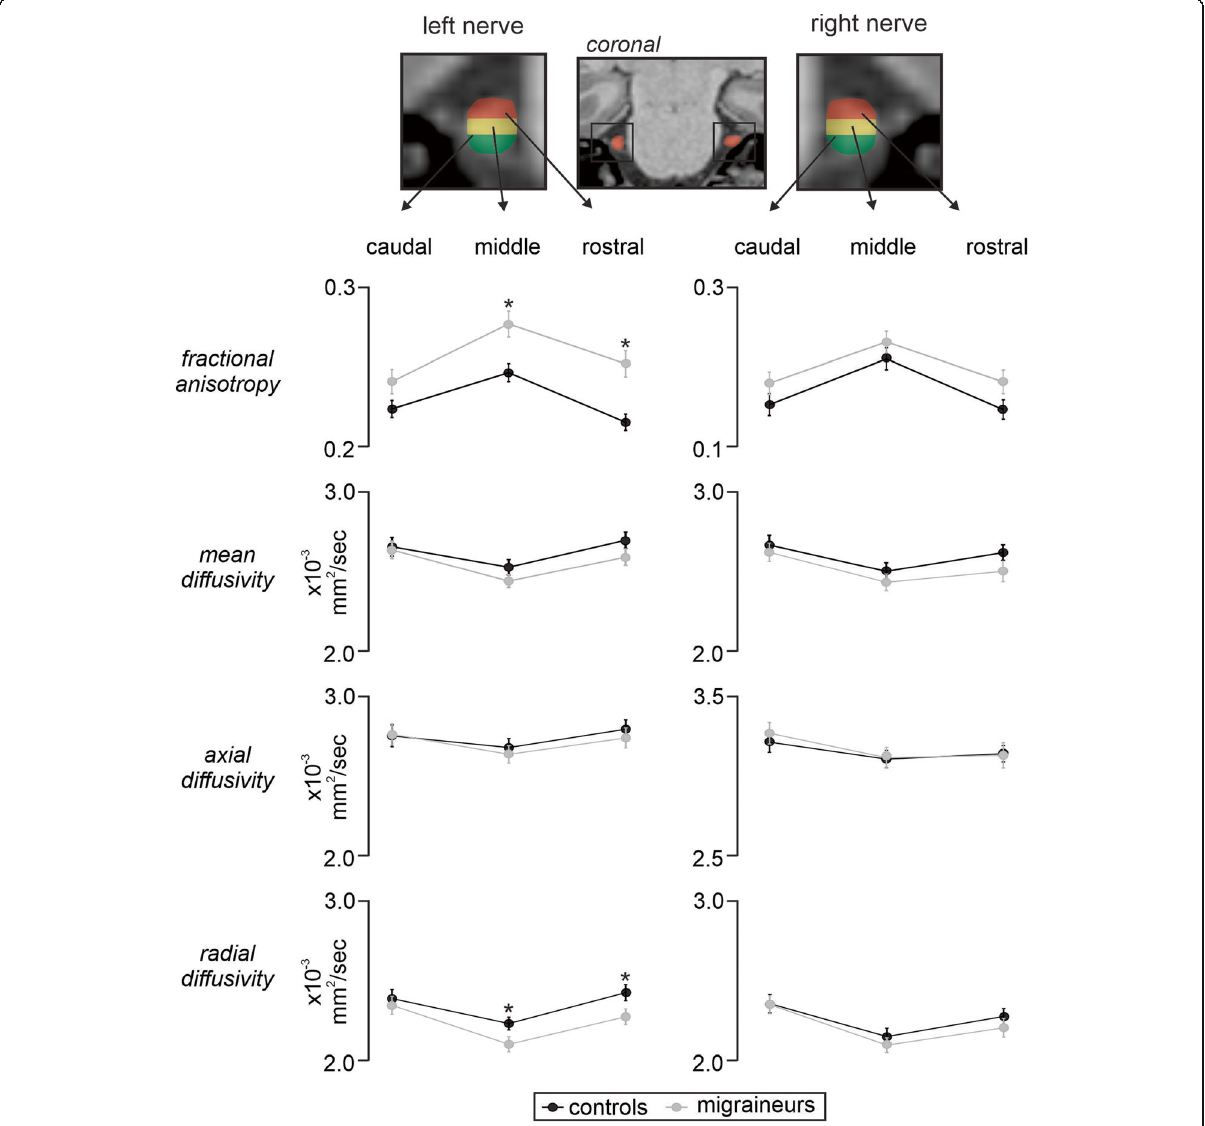
Fig. 4 Line graphs showing mean (±SEM) fractional anisotropy, mean diffusivity, axial diffusivity and radial diffusivity of the left and right trigeminal root for caudal, middle and rostral divisions in controls (black lines) and migraineurs (grey lines). Note that fractional anisotropy was significantly different, i.e., lower in migraineurs than controls at the middle and rostral divisions, whereas radial diffusivity was greater in migraineurs at the middle and rostral divisions. * p < 0.05. The top panel shows a T1-weighted coronal image with the trigeminal nerve indicated by the red shading. To the left and far right is an expanded view of the left and right trigeminal nerve showing the caudal (green), middle (yellow) and rostral (red)